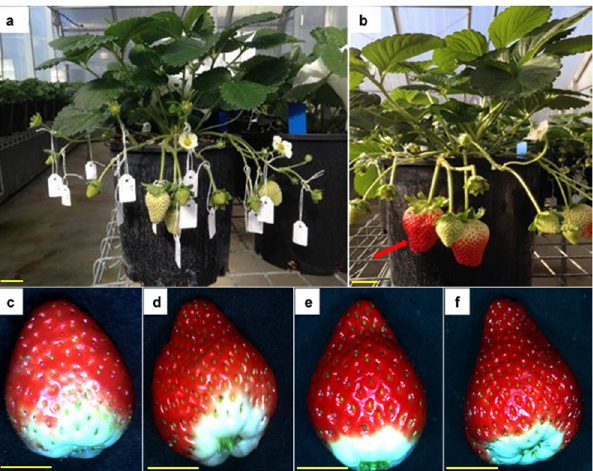
Fig 2. Experimental potted plants of strawberry in the glasshouse, with fruits at (a) immature stage and (b) mature stage (ripe fruit indicated by arrow). Typical colour of cultivar Redlands Joy fruit arising from (c) unassisted self- pollination, or hand-pollination with (d) self-pollen or cross-pollen from (e) cultivar Sugarbaby or (f) cultivar Rubygem. Scale bars = 1 cm. Photographs: Cao Dinh Dung.